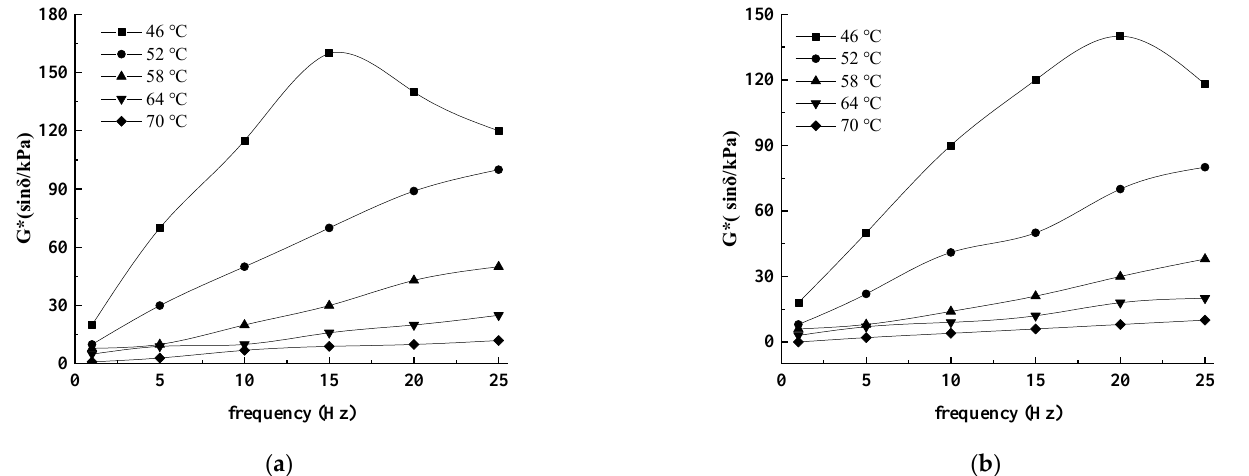
Figure 9. The variation curve of different asphalt rutting factors with frequency: ( a ) rubber-powder-modified asphalt; ( b ) SBS-modified asphalt.